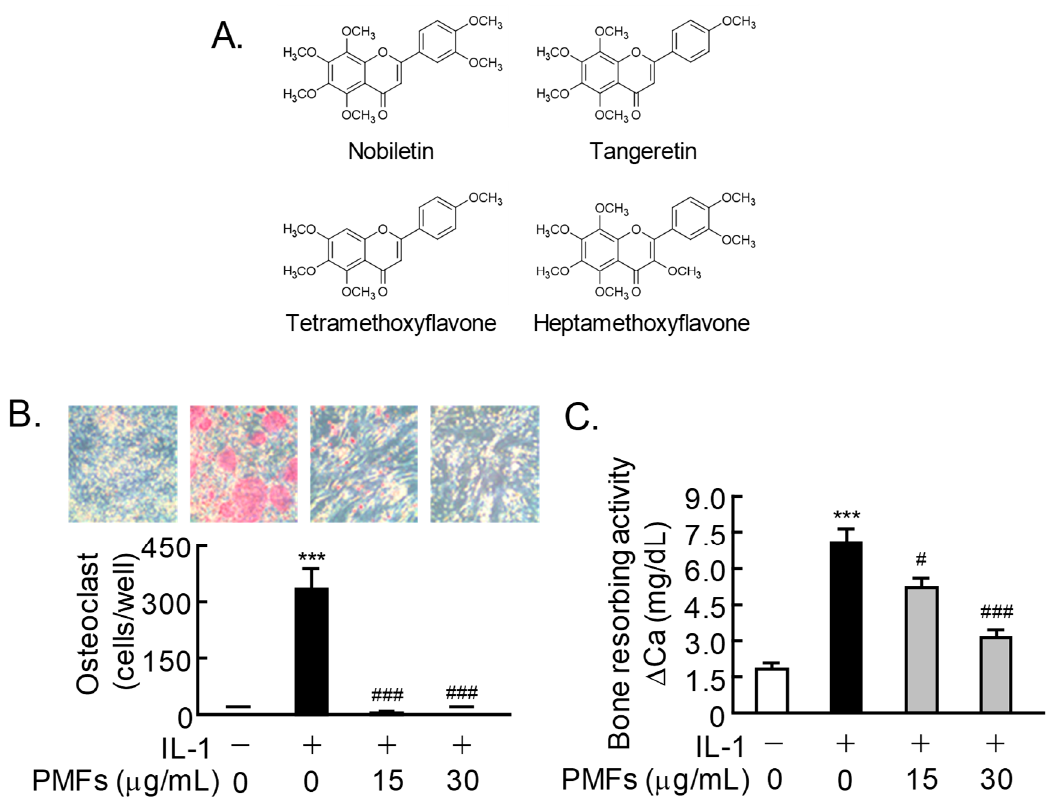
Figure 1. Effects of PMFs on the IL-1-induced osteoclast differentiation and bone resorption. ( A ) Structures of nobiletin, tangeretin, tetramethoxyflavone (TMF), and heptamethoxyflavone (HMF). ( B ) Mouse POBs and BMCs were cocultured for 7 days with IL-1 (2 ng/mL) in the presence of PMFs (15, 30 µ g/mL). TRAP-positive multi-nuclear osteoclasts were classified as osteoclasts. The upper panels show TRAP-stained osteoclastic cells. The data are expressed as the means ± SEM (standard error of the mean) of 4 wells. ( C ) Newborn mouse calvariae were cultured for 5 days with IL-1 (4 ng/mL) and PMFs (15, 30 µ g/mL). The bone-resorbing activity was determined based on the calcium concentration in the medium using OCPC methods. The data are expressed as the means ± SEM of 5 independent cultures. Significant differences between the two groups are indicated; *** p < 0.001 vs. control, # p < 0.05 and ### p < 0.001 vs. IL-1.